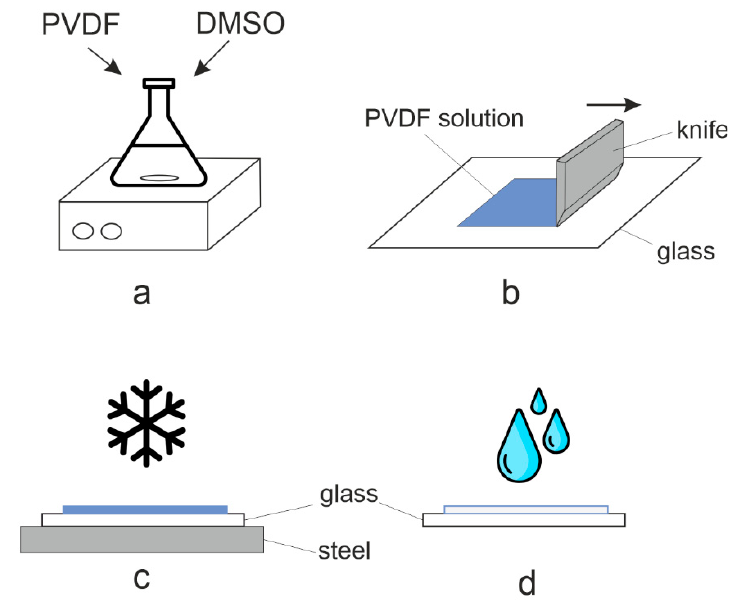
Figure 1. Steps of PVDF membranes production by freezing (( a – d ) detailed explanation are in the text).